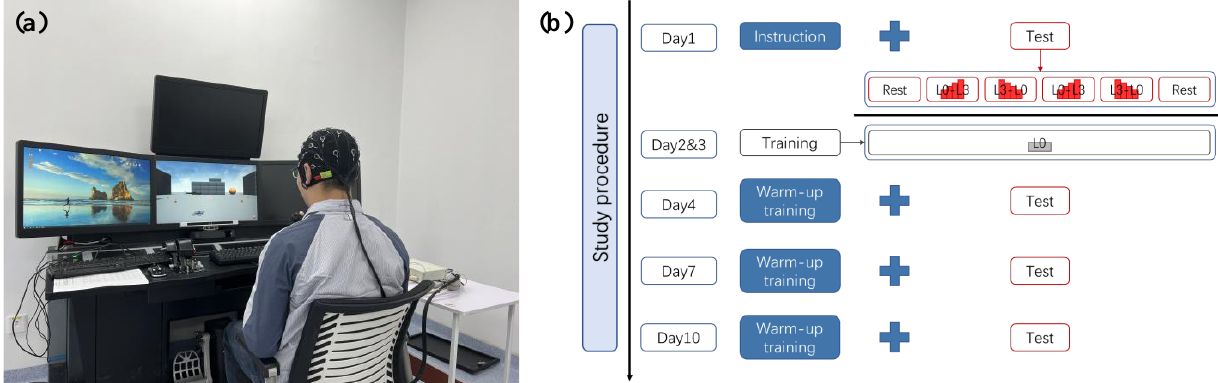
Figure 1. Illustration of the experimental environment, task scenarios, and experimental procedure arrangements. ( a ) Simulated UAV operation tasks and experimental environment. ( b ) Schematic of the study procedure (adopted from Gu et al., 2022 [32]).